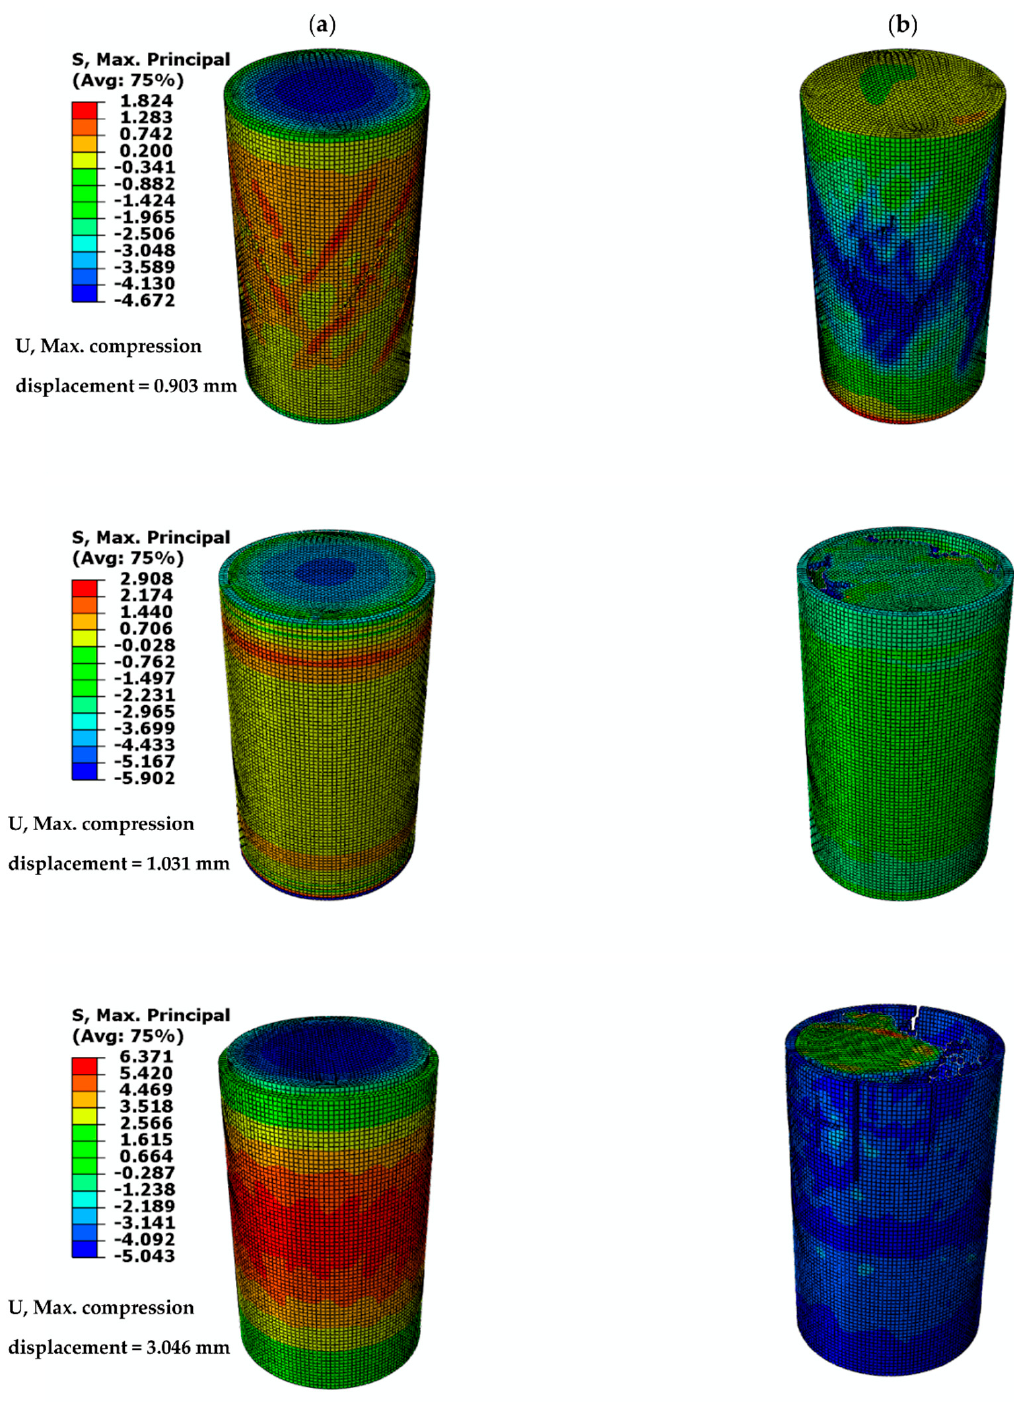
Figure 19. The failure mode of 220 mm samples with max principle stress. ( a ) before failure ( b ) after failure.